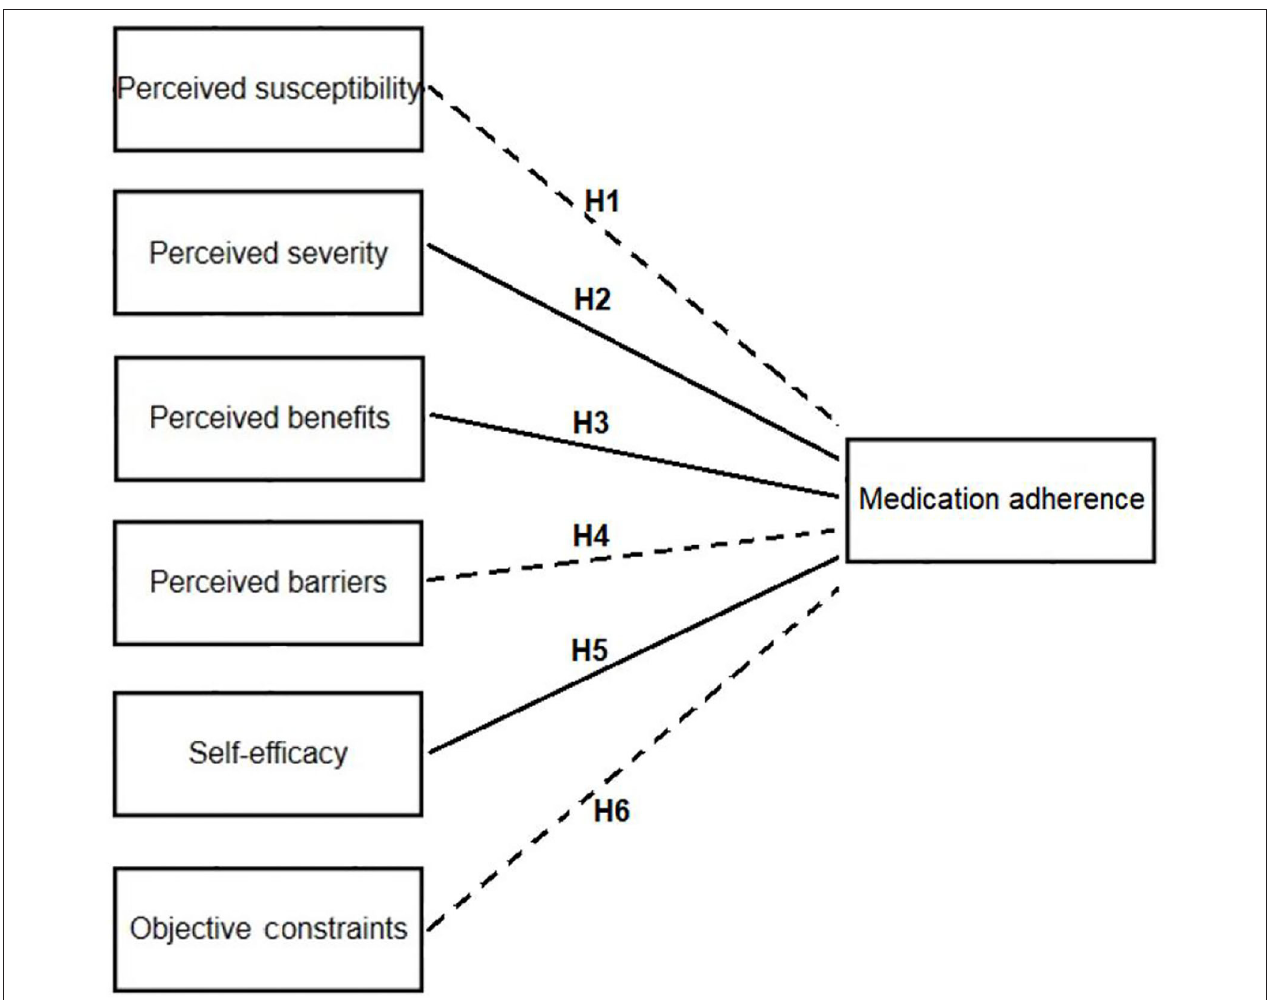
FIGURE 1 | Research model diagram of the relationship between parents’ health beliefs and their children’s medication adherence. H1–H6 are six hypotheses of this study: H1: parents’ perceived susceptibility has a negative impact on their children’s medication adherence. H2: parents’ perceived severity has a positive impact on their children’s medication adherence. H3: parents’ perceived benefits have a positive impact on their children’s medication adherence. H4: parents’ perception disorder has a negative impact on their children’s medication adherence. H5: parents’ self-efficacy has a positive impact on their children’s medication adherence. H6: parents’ objective constraints have a negative impact on their children’s medication adherence.